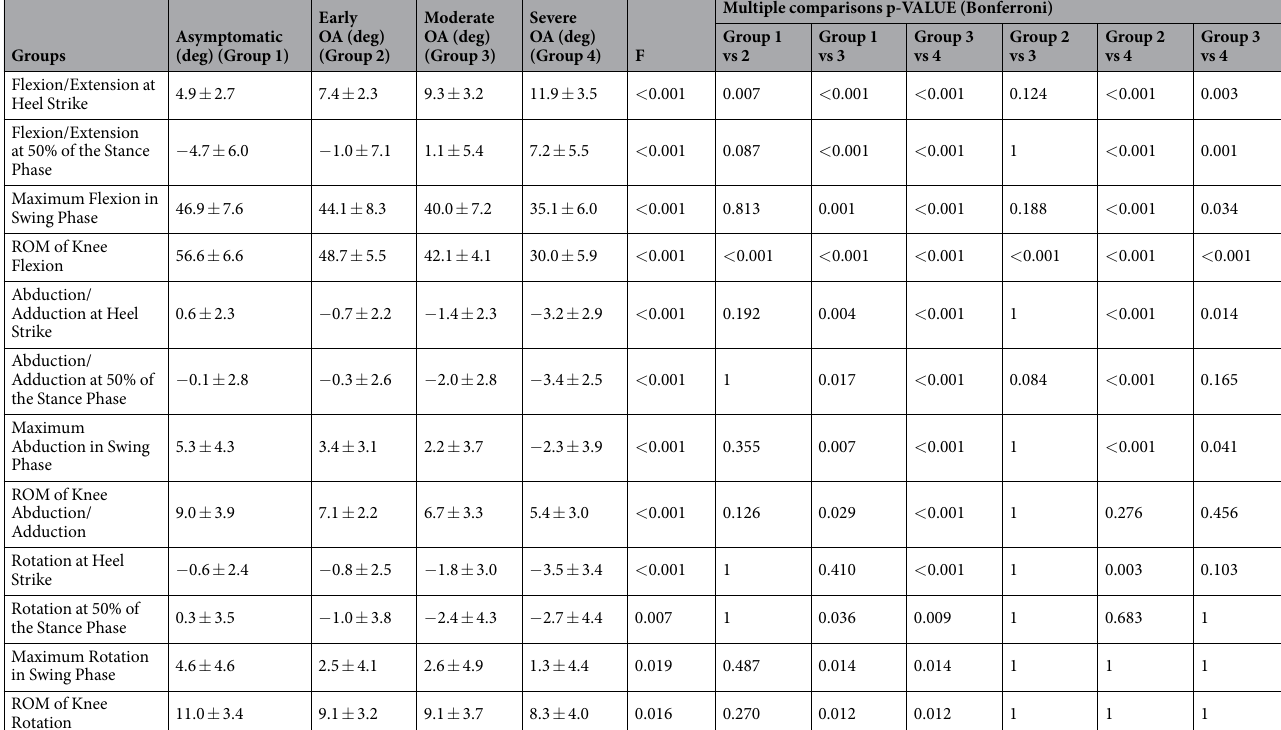
Table 2. Mean ± SD of angular kinematic parameters between knee OA severities (in degrees). In this table, the key events of the gait at the heel strike and 50% of the stance phase, the maximum angle at the swing phase, and the range of motion were compared. The multiple statistical differences between groups were performed by Bonferroni